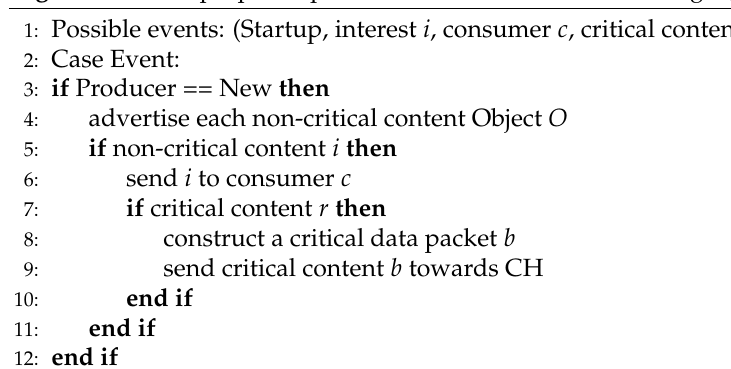
Algorithm 1 The proposed push-based critical data forwarding algorithm at a